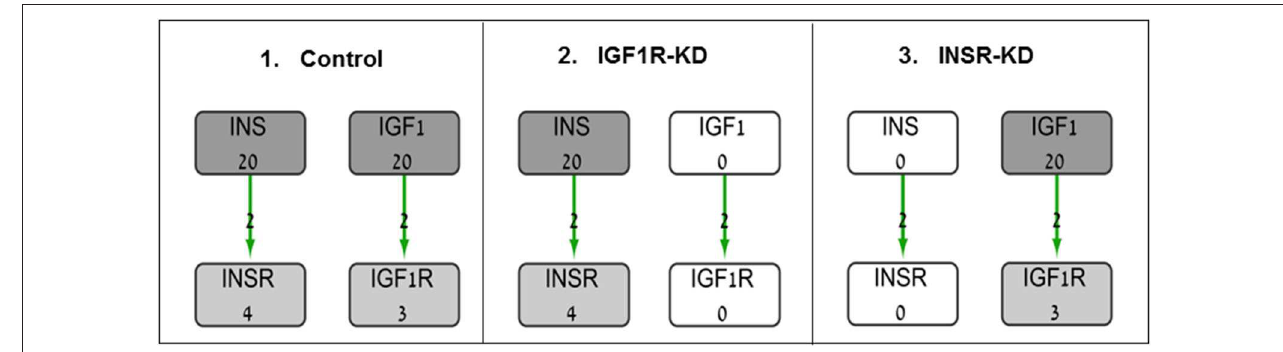
FIGURE 1 | Diagram of BioNSi simulations experimental design. Network nodes are shown as rectangles with gene name and an initial normalized expression value below it. Grayscale coloring of nodes represents gene expression of control MCF7 cells. Green edges are shown as directed arrows, representing gene activation (with level 2, as indicated in section Materials and Methods). Initial expression values for the key genes affecting gene expression [INSR, insulin (INS), IGF1R, and IGF1] are presented (simulations: 1, control; 2, INSR-KD; and 3, IGF1R-KD). Initial expression of INS and IGF1 were set manually to 0 (KD) or 20 (very